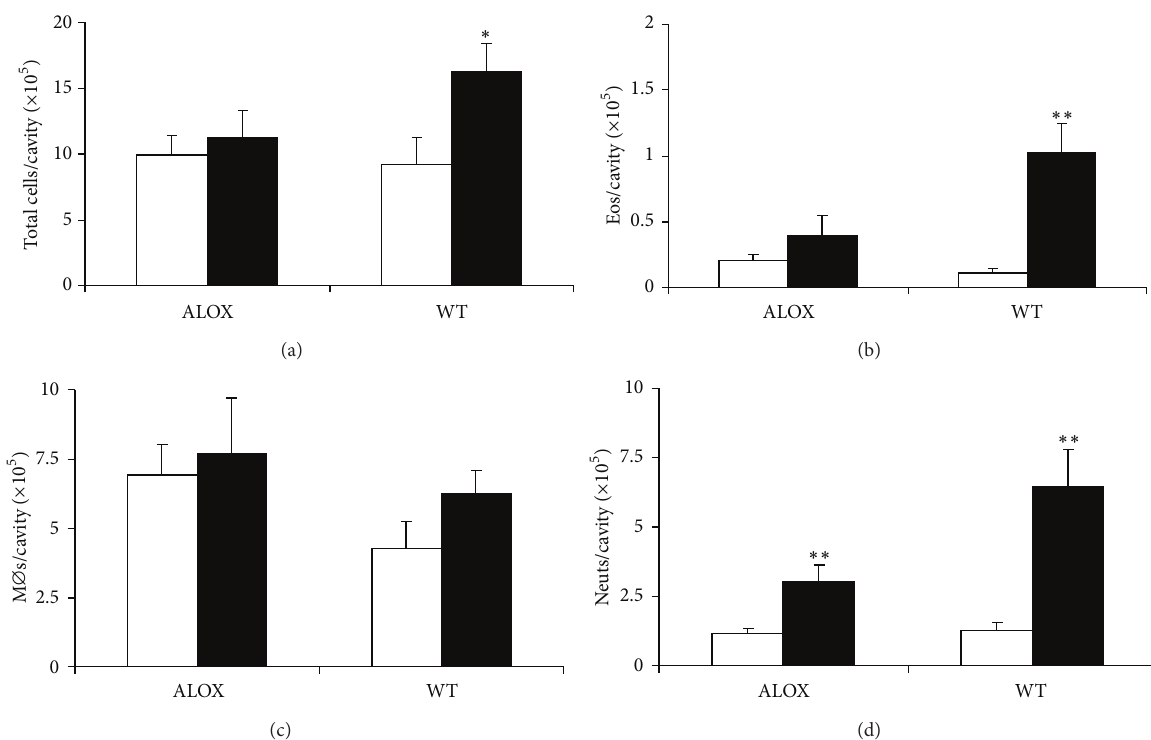
Figure 5: Mixed leukocyte accumulation induced by eotaxin in ALOX and PAS mice . 5-LO-deficient mutant (ALOX) and wild-type (WT) control PAS mice were injected with RPMI (open bars) or eotaxin, 50 ng/cavity (black bars). The peritoneal lavage fluid collected after 4h was used for quantitation of total leukocytes (a), eosinophils (b), macrophages (c), and neutrophils (d). Data are mean + SEM. ∗ , 𝑃 ≤ 0,05 ; ∗∗ , 𝑃 ≤ 0, 01 . Data from 10